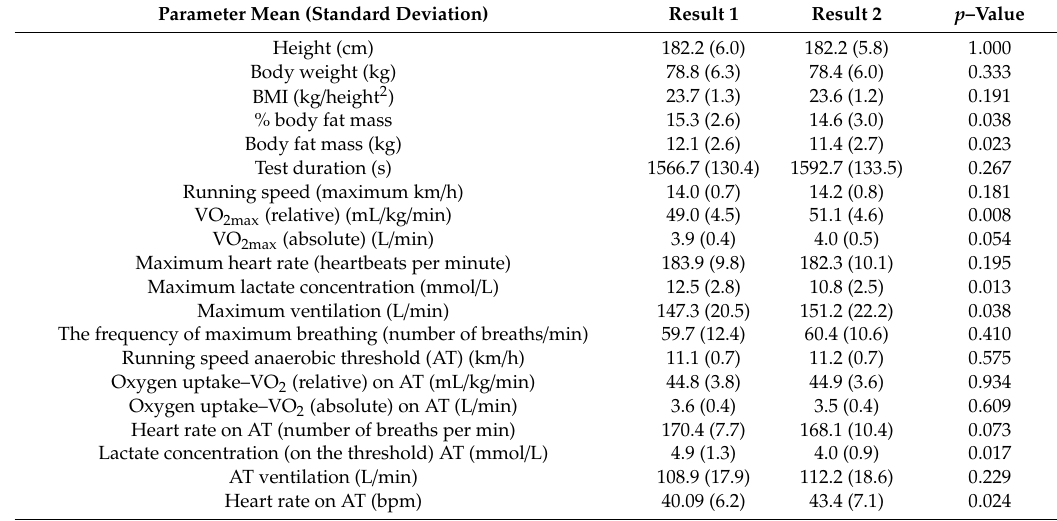
Table 1. Comparison of the results of the first and second